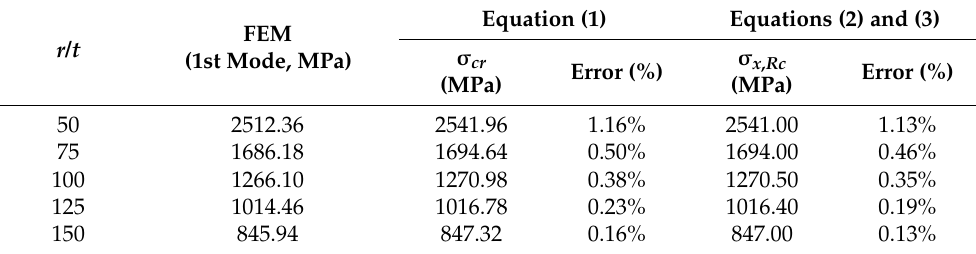
Table 5. Comparison of elastic buckling stress ( L = 9).